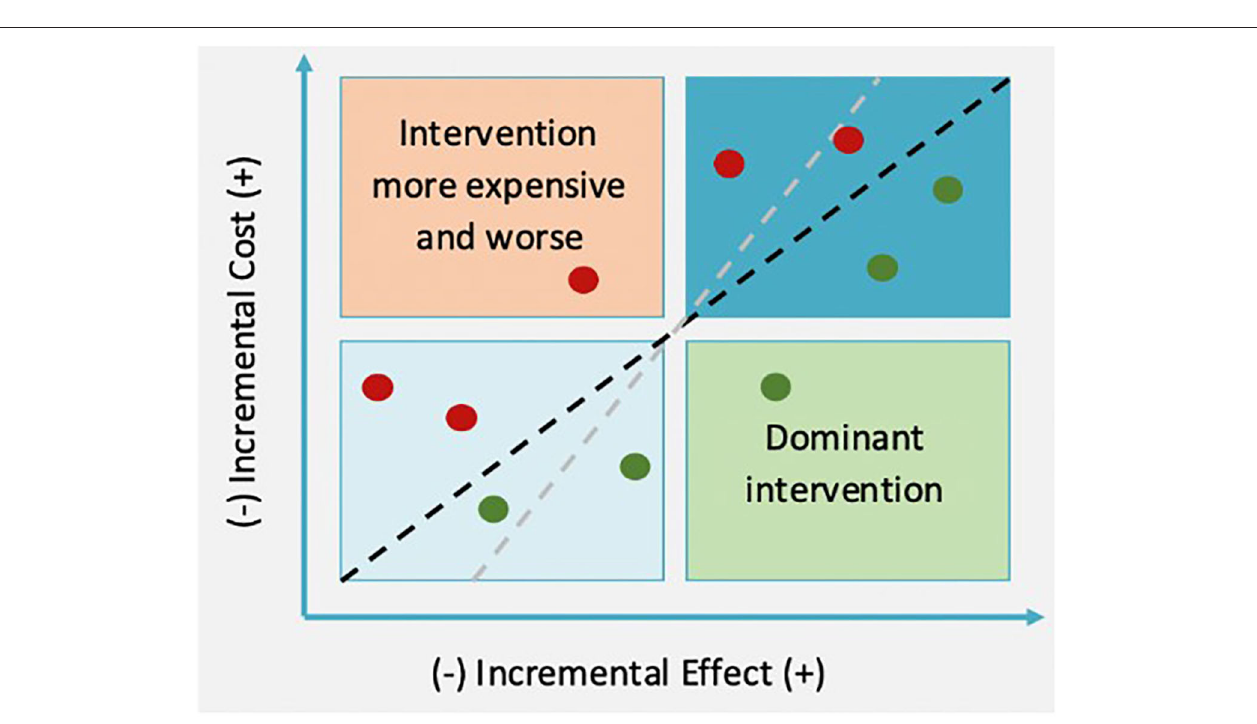
FIGURE 3 | Cost-effectiveness table and